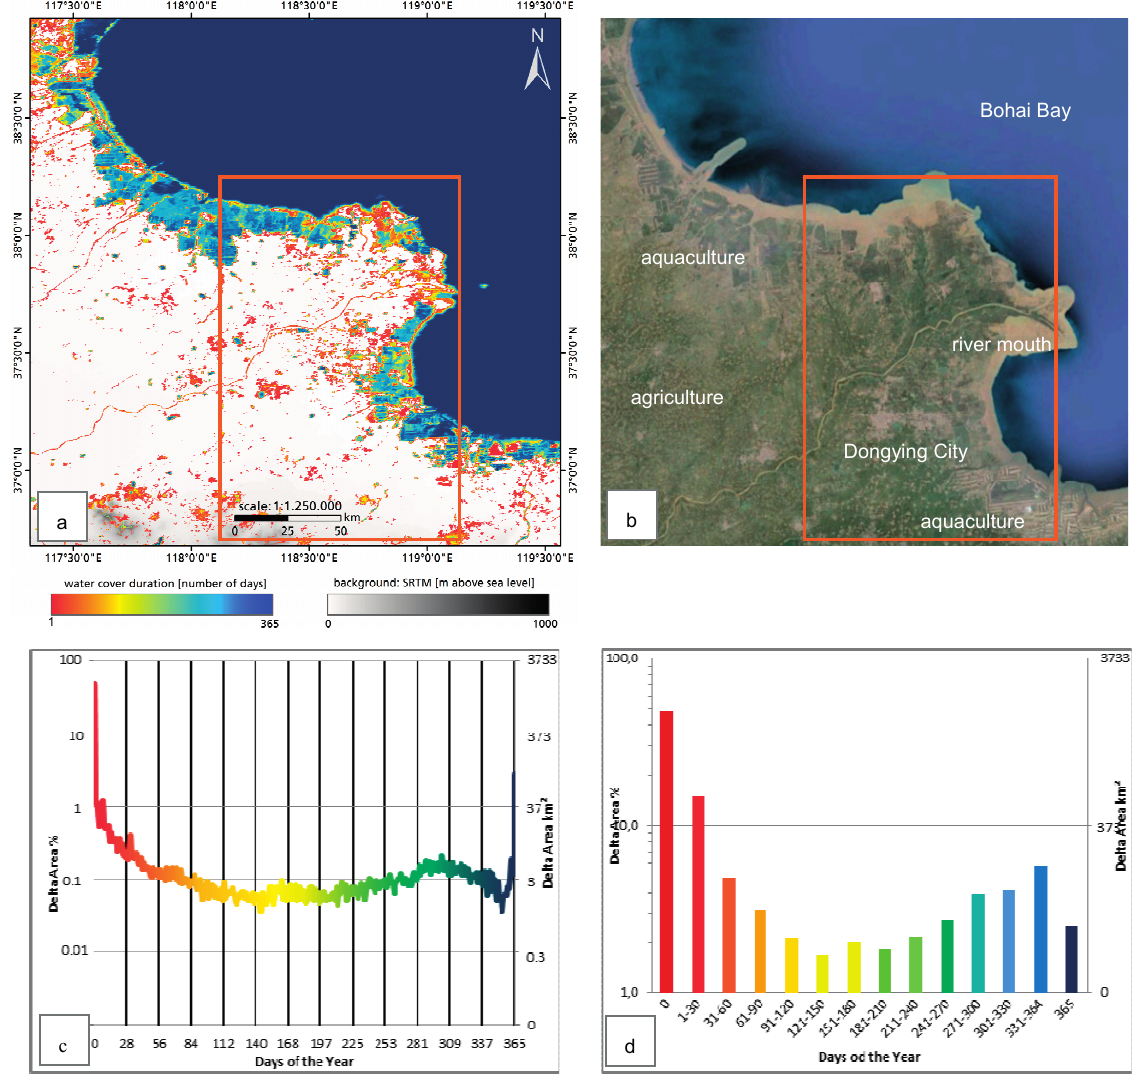
Figure 2. Intra-annual inundation patterns of the Yellow River Delta, China, derived from an annual time series of daily temporal resolution for the year 2013. Orange subset indicates validation area presented in Figure 3. ( a ) intra-annual inundation dynamics, ( b ) optical data for comparison, ( c ) and ( d ) quantitative analyses of inundation dynamics Figure 2a depicts the intra-annual inundation patterns and distribution of the Yellow River